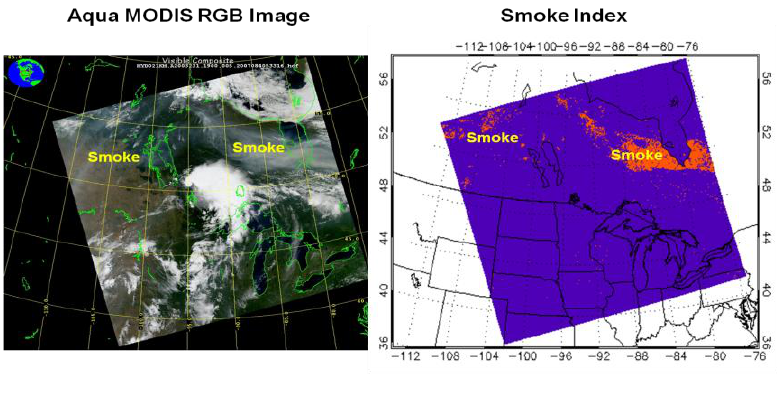
Figure 18. A RGB image of an Aqua MODIS granule on August 19, 2003 at 19:00 UTC is given in the left panel. The results of the smoke detection are shown in the right panel where pixels flagged as smoky are red.